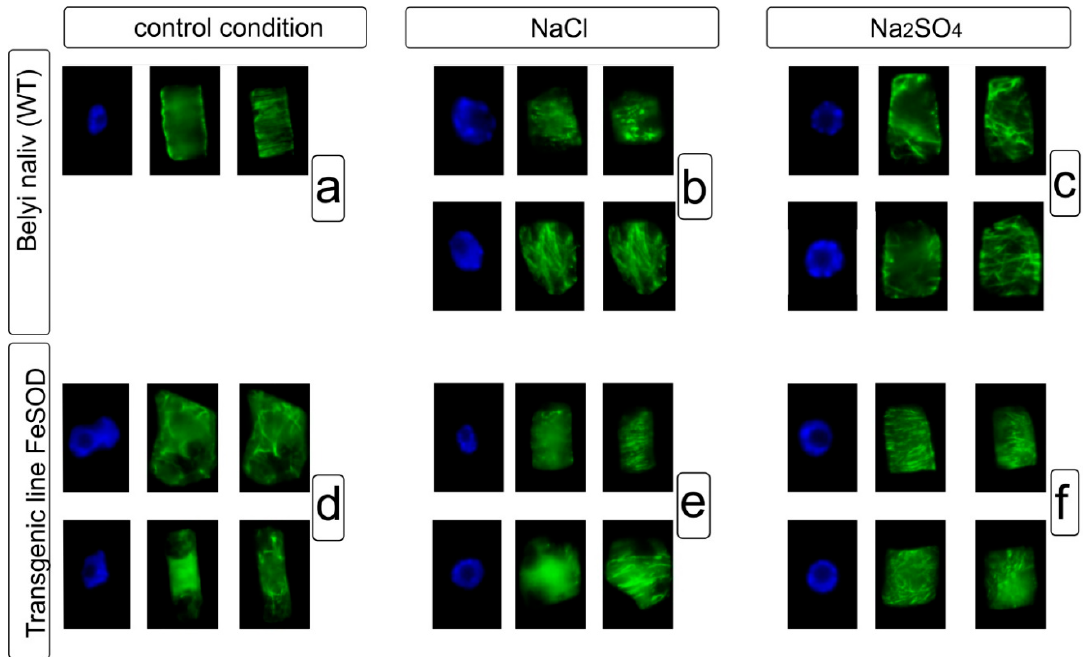
Figure 4. Tubuline cytoskeleton in cell cycle interphase of root cells from WT ( a – c ) and transgenic tomato ( d – f ) plants grown without, and with the addition of NaCl and Na 2 SO 4 . Nuclei were stained with DAPI ( blue ); microtubules were detected using antibodies to α -tubuline ( green ). While the bundles of microtubules are located in the cortical cytoplasm, microtubules are not visible in the perinuclear region in the interphase cells. Tomato root cells have obvious multiple lesions in the location of microtubules under the NaCl, Na 2 SO 4 . Cells form multiple chaotically arranged bundles and do not maintain peripheral position, which indicates violations in the process of cytoskeleton transformation, as a highly dynamic structure.